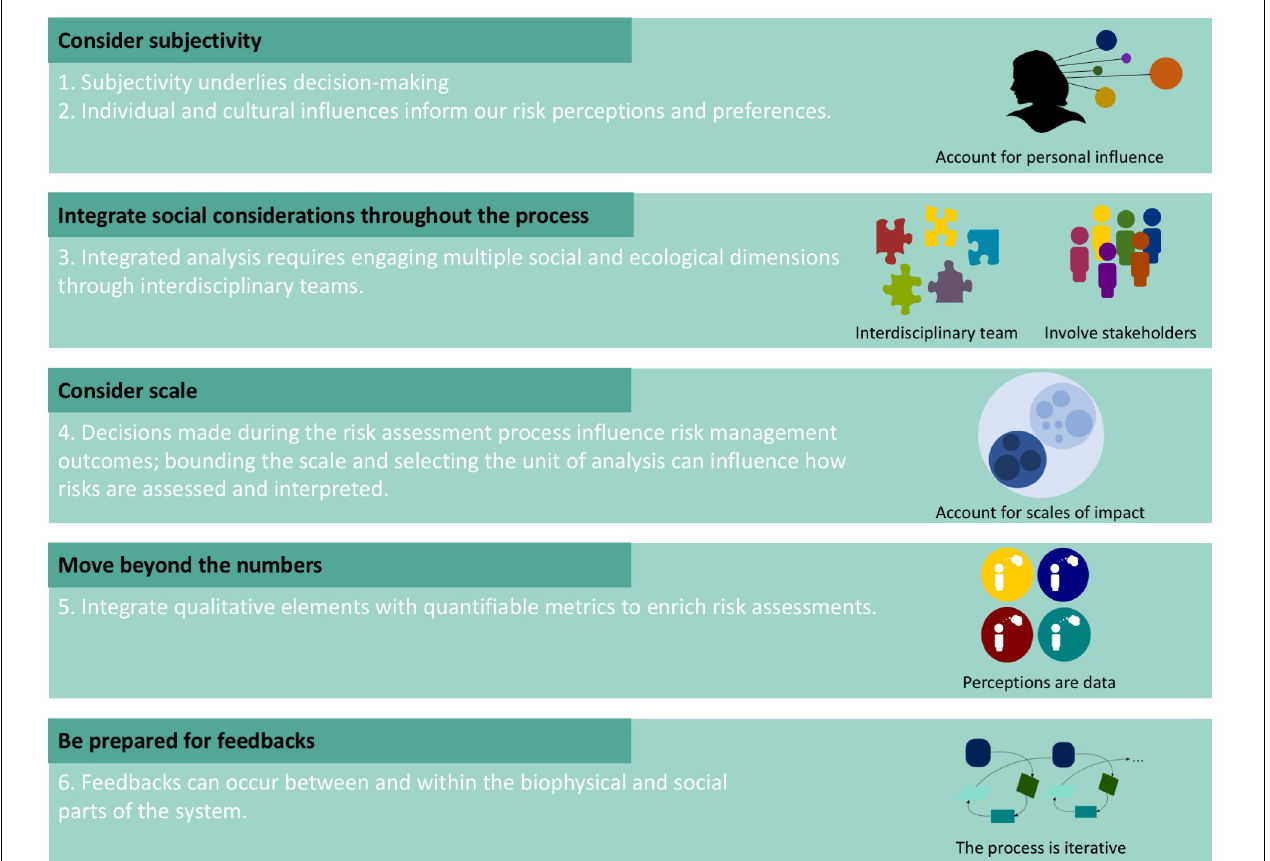
FIGURE 2 | Fundamentals for an integrated approach to risk assessment, our six insights and how to begin to account for